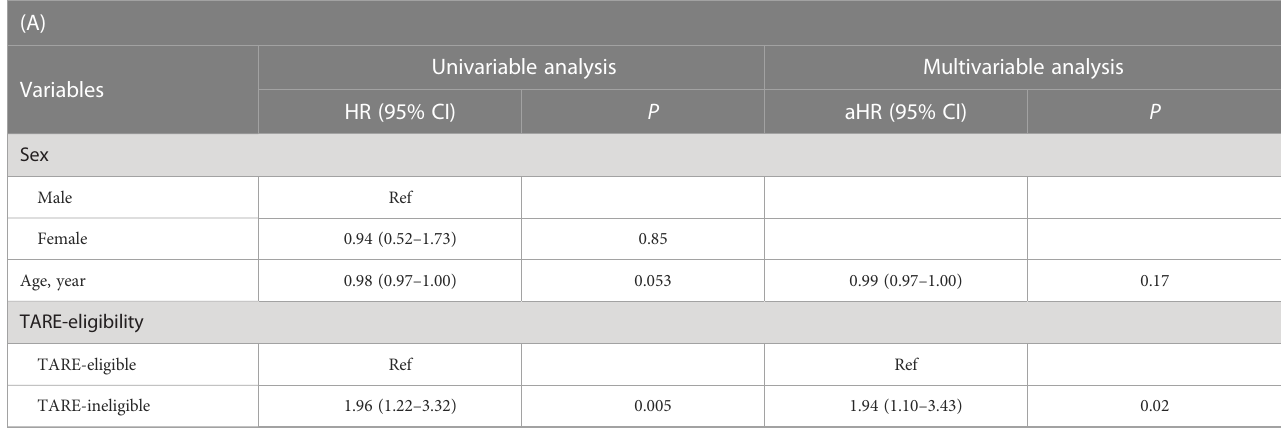
TABLE 3 Univariable and multivariable Cox analyses for the time-to-progression between TARE-eligible and TARE-ineligible groups before (A) and after (B) IPTW. (A)